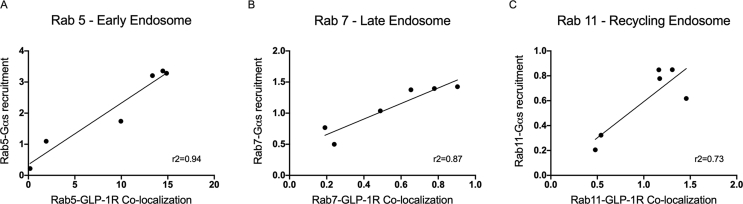
Degree of Rab-specific GLP-1R co-localization was positively associated with the degree of GLP-1R-mediated endosomal Gαs recruitment in HEK293T cells. Linear regression between Gαs recruitment and GLP-1R co-localization at the Rab5- (A), Rab7- (B), and Rab11-positive (C) endosomal compartments.